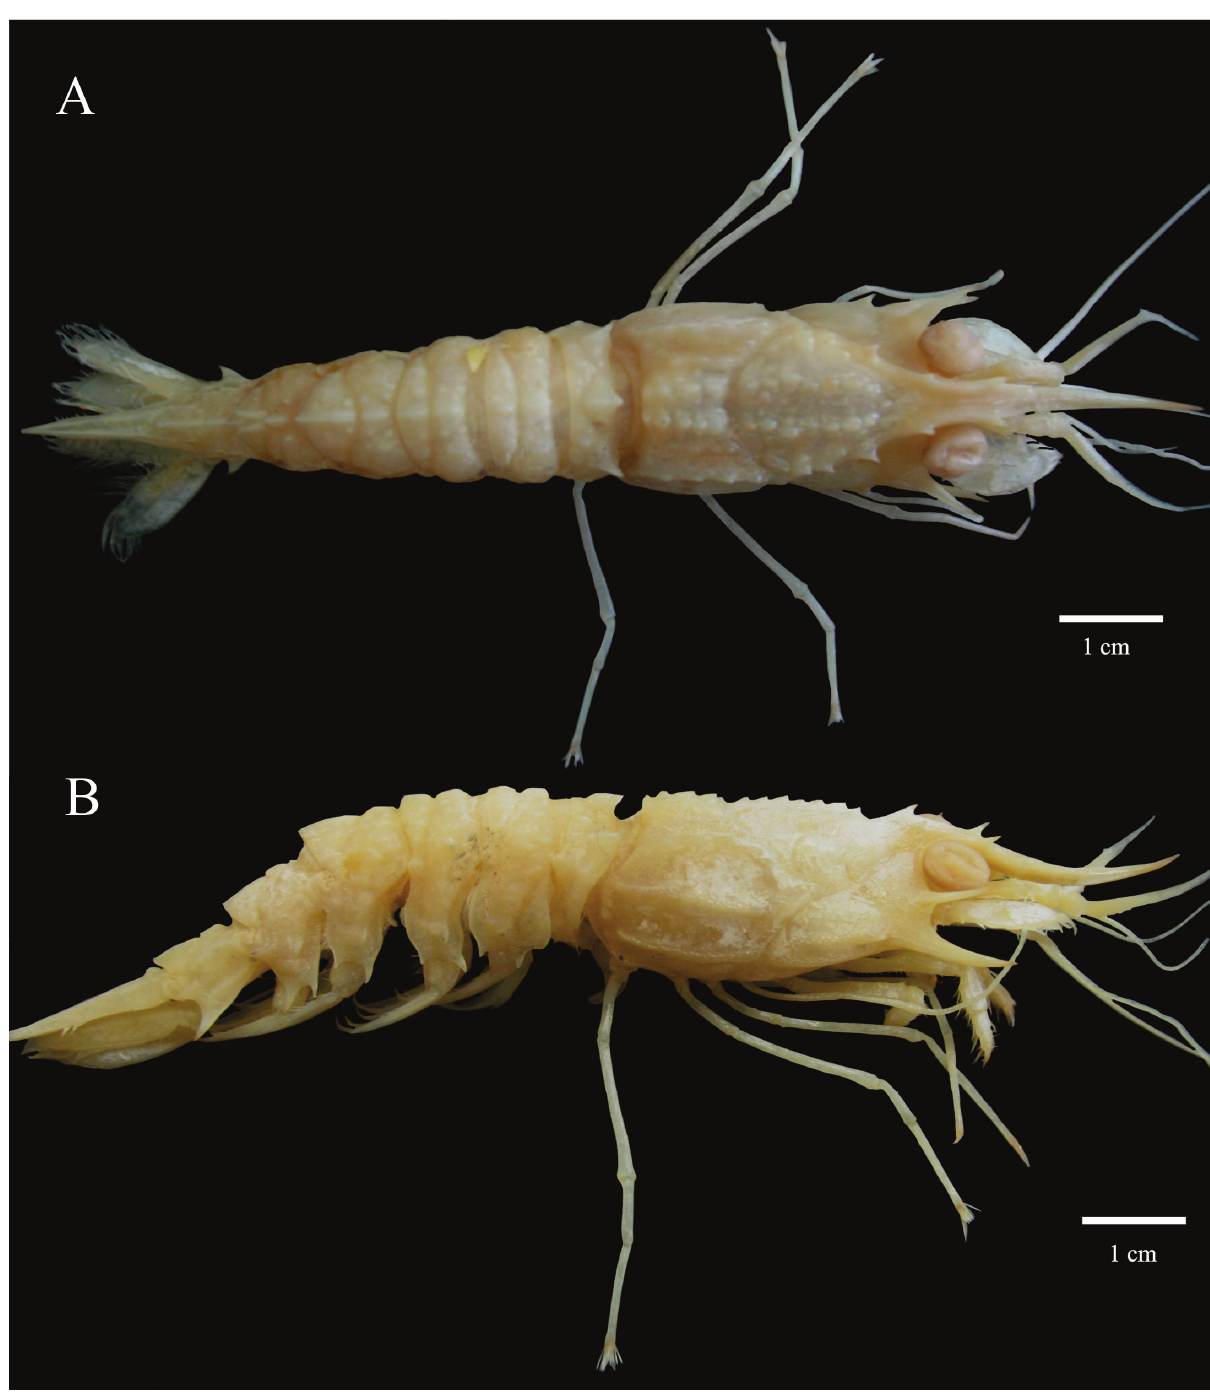
Figure 4. Glyphocrangon longirostris (Smith, 1882), dorsal (A) and lateral (B) views, male (TL-70 mm; Bpot-Talude MT # 74; MOUFPE 15.165), northeastern